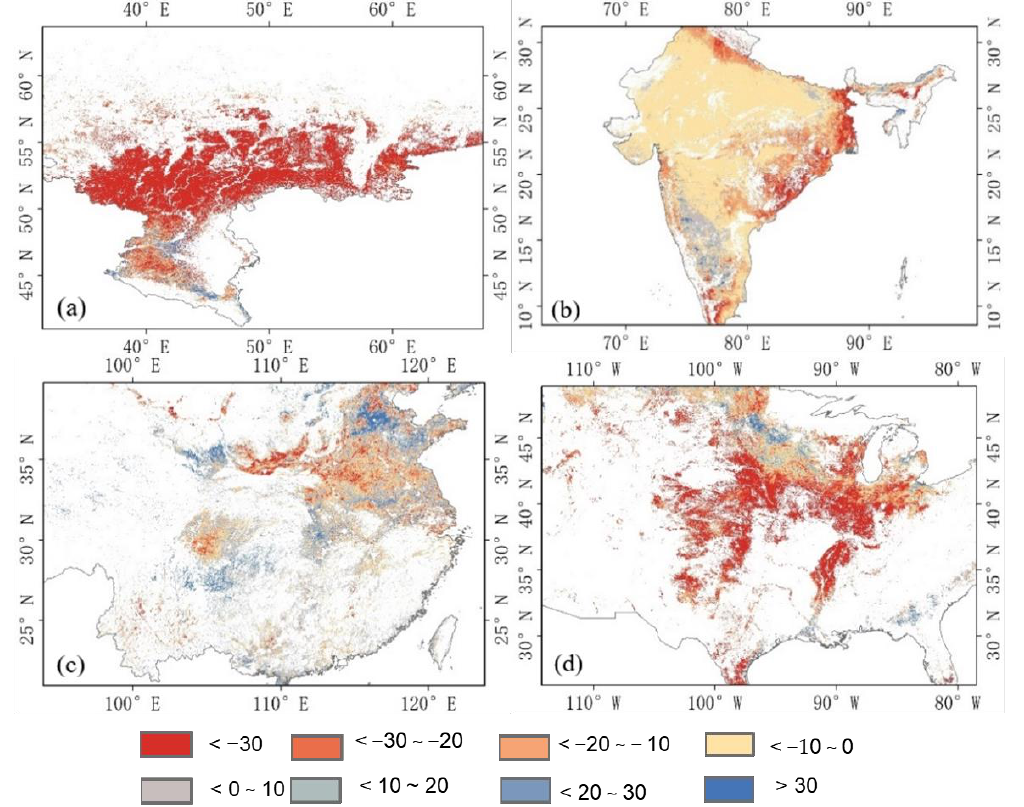
Figure 11. The percentage of anomalies of monthly mean GPP relative to monthly GPP of multi- year mean values for four major heat-wave and drought events: ( a ) 2010 (June – August) Russia heat-wave; ( b ) 2009 (April – June) India heat-wave; ( c ) 2013 (January – June) China drought; ( d ) 2012 (June – December) US Corn Belt drought.